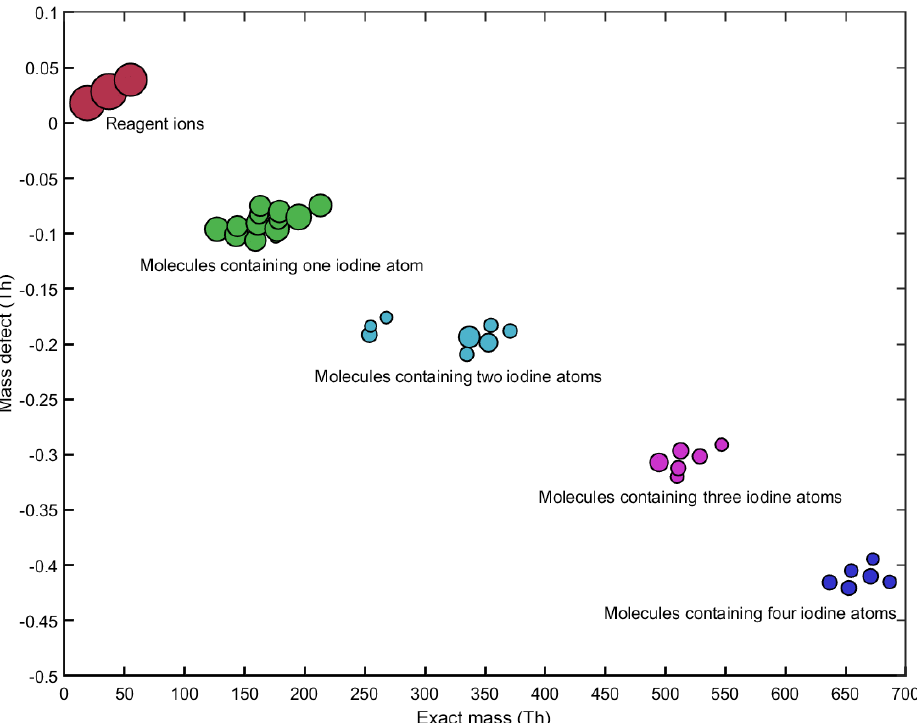
Figure 7. Mass defect plot for the iodine compounds, as well as the most prominent reagent ions, during a CLOUD experiment on new particle formation from iodine. The estimated iodic acid mixing ratio is ∼ 0 . 98pptv. The y axis shows the mass defects of the compounds (see Table 2 and the text for details), while the x axis shows the absolute masses. The size of the symbols is proportional to the measured signal intensities on a logarithmic scale (from 1 . 24 × 10 − 6 to 14.04ionss − 1